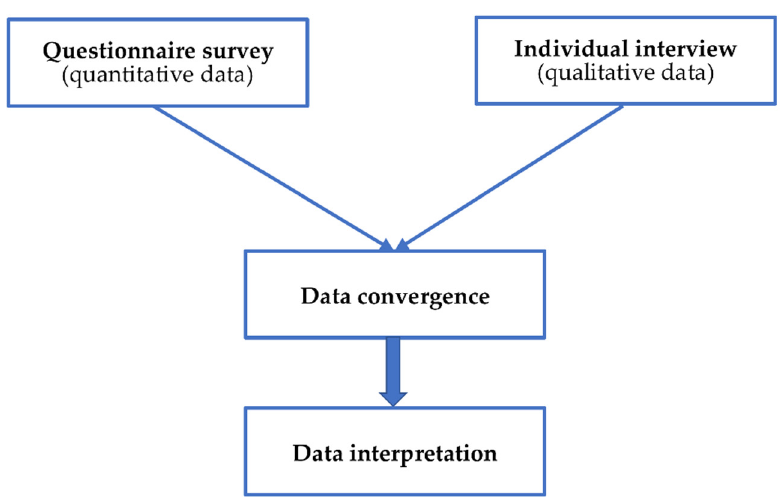
Figure 2. Concurrent triangular design of a mixed methods study.